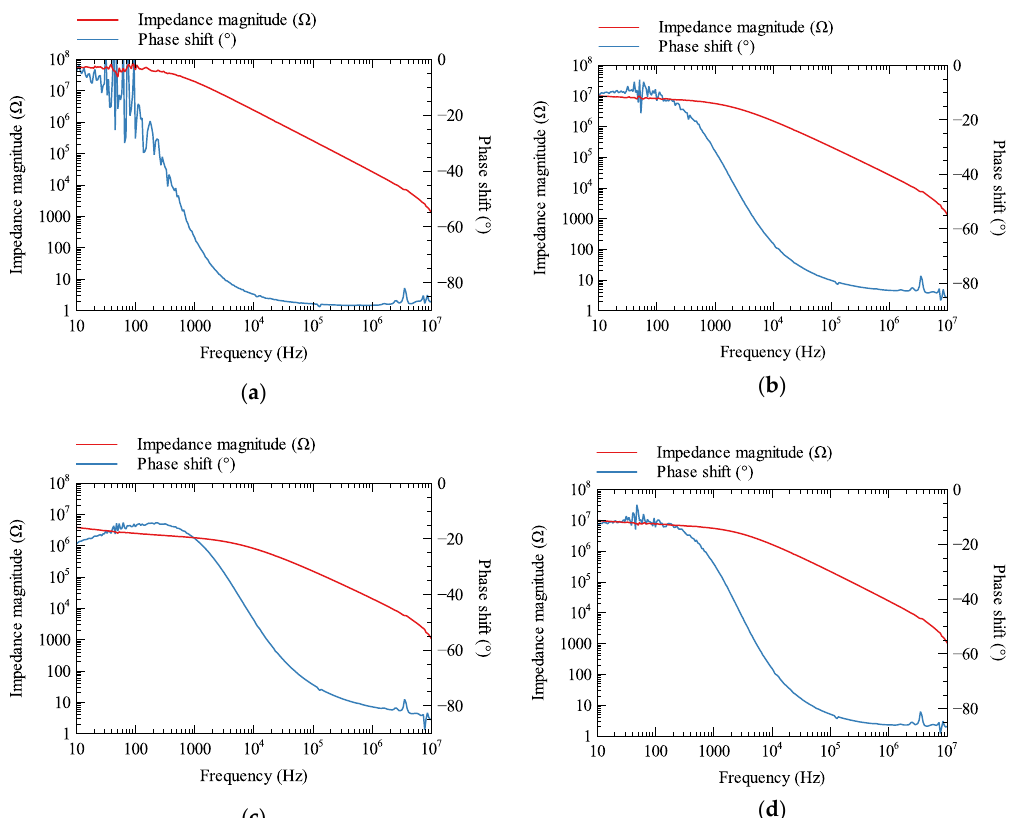
Figure 13. AC electrical properties: impedance magnitude/phase shift dependencies on the frequency. ( a ) M2; ( b ) M3; ( c ) M4; ( d ) M5.